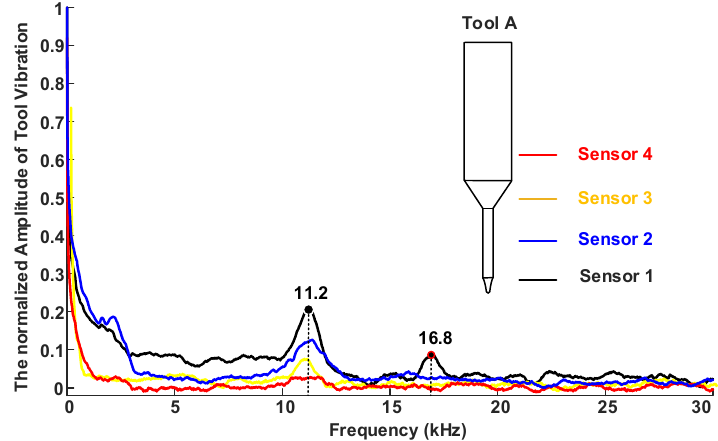
Figure 13. Frequency propagation of Tool A based on impact response. Compared with the frequency propagation curves in Figure 13 and the vibration displacement curves in Figure 12, most information components are in measuring point 1.